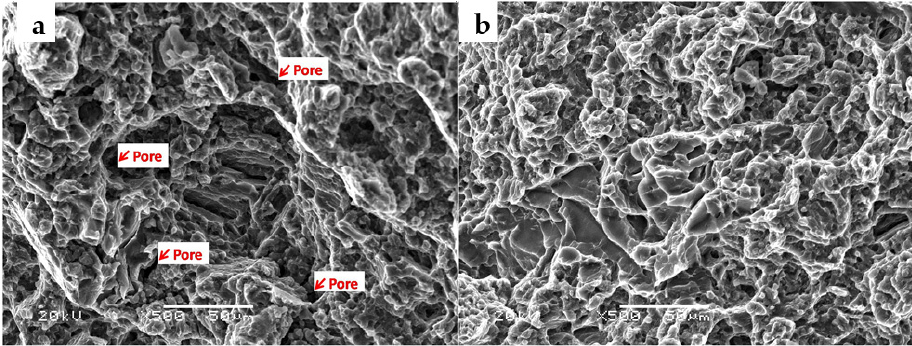
Figure 13. SEM images of tensile fracture for ( a ) liquid die casting and ( b ) rheo ‐ diecasting AM60 alloy.